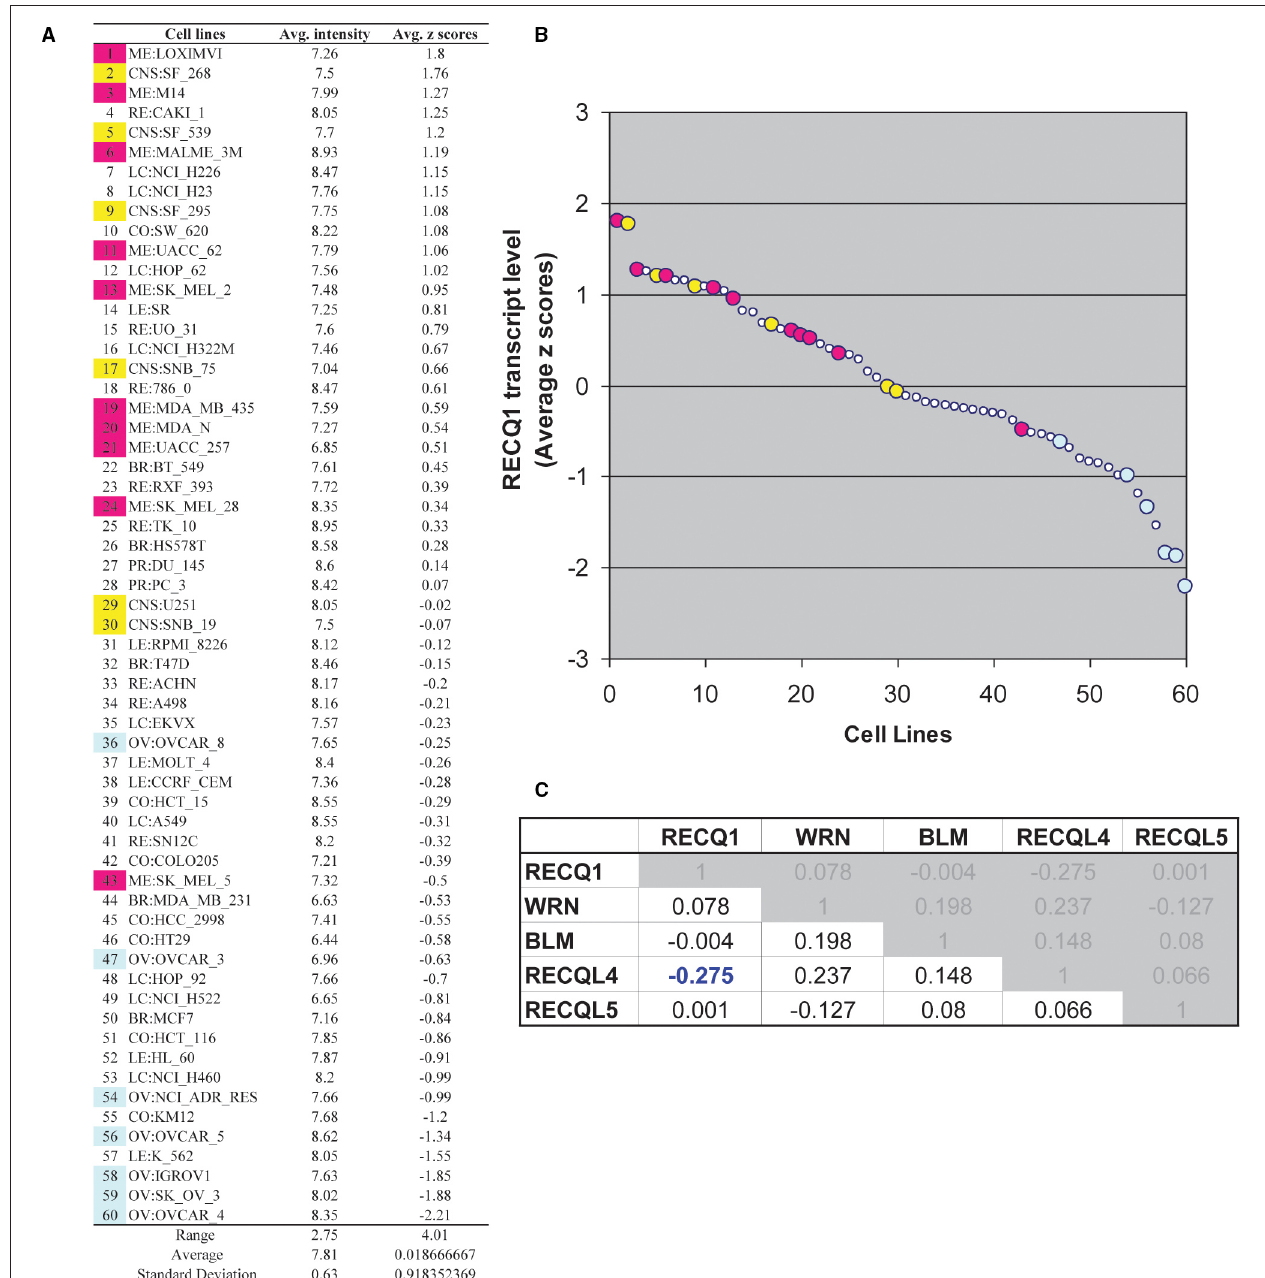
among RecQ family. Pearson’s correlation coefficients between transcripts of the known five RecQ homologs in the NCI-60. Only significant correlation of RECQ1 in the NCI-60 is with the RECQL4 transcripts. Processing and normalization of transcript expression data from the NCI-60 has been described previously (Reinhold et al., 2012). Normalization of Affymetrix HG-U95, HG-U133, HG-U133 plus 2.0 and Affy HuEx 1.0 is done by GC robust multi- array average (GCRMA). Data is accessible at http://discover.nci.nih.gov by using RECQL (RECQ1) as input in